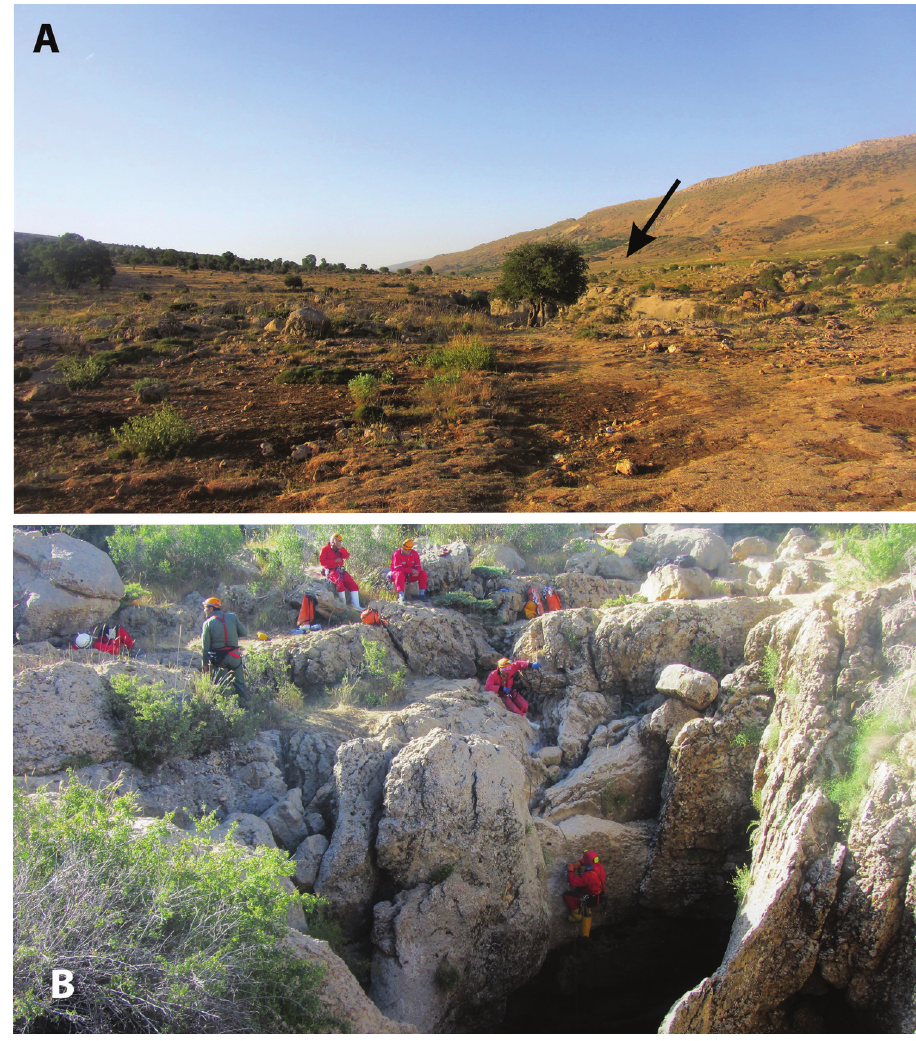
Figure 6. A Habitat of Spariolenus mansourii sp. n., Nezel pit cave entrance (arrow) B Nezel pit cave entrance, the type locality, Naghsh-e-Jahan caving club entering the